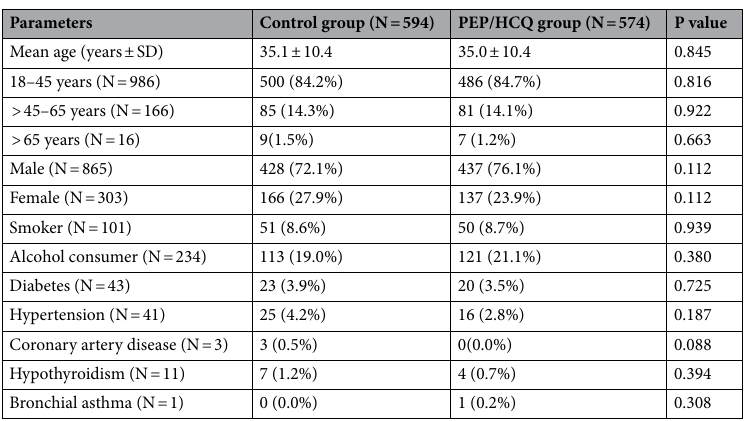
Table 1. Baseline demographic and clinical parameters of the study population.